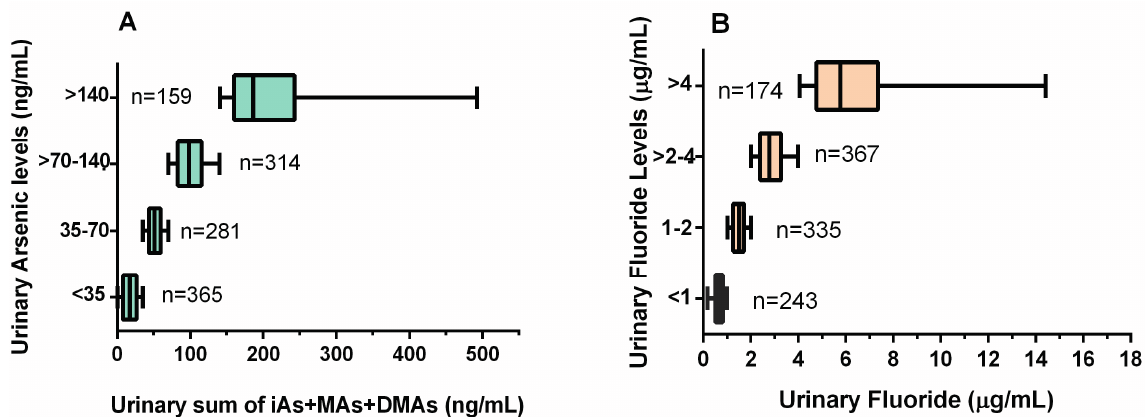
Figure 3. The distribution of total speciated arsenic ( A ) and fluoride levels ( B ) in the urine samples—stratified by 1×, 2× and 4× Biological Exposure Index value. Median values (vertical lines) and the interquartile range (boxes) are shown. The whiskers represent minimum and maximum values.